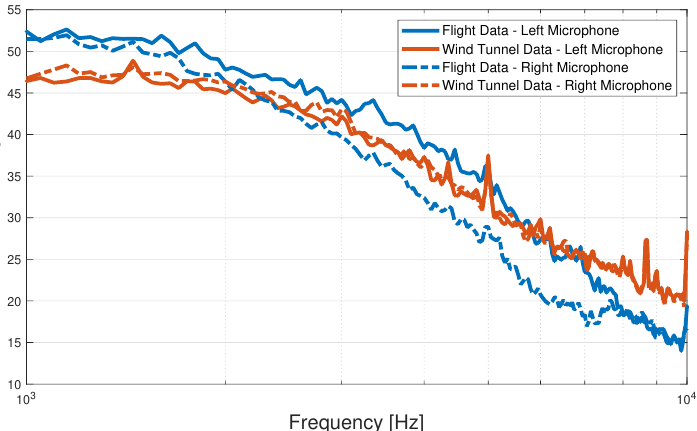
Figure 7. PSDs of the wind tunnel and flight data segments for both the left- and right-mounted microphones at an airspeed of 12 m/s computed using Welch’s method. The wind tunnel data segment corresponds to an AoA of 0 ◦ and UAV motor configuration